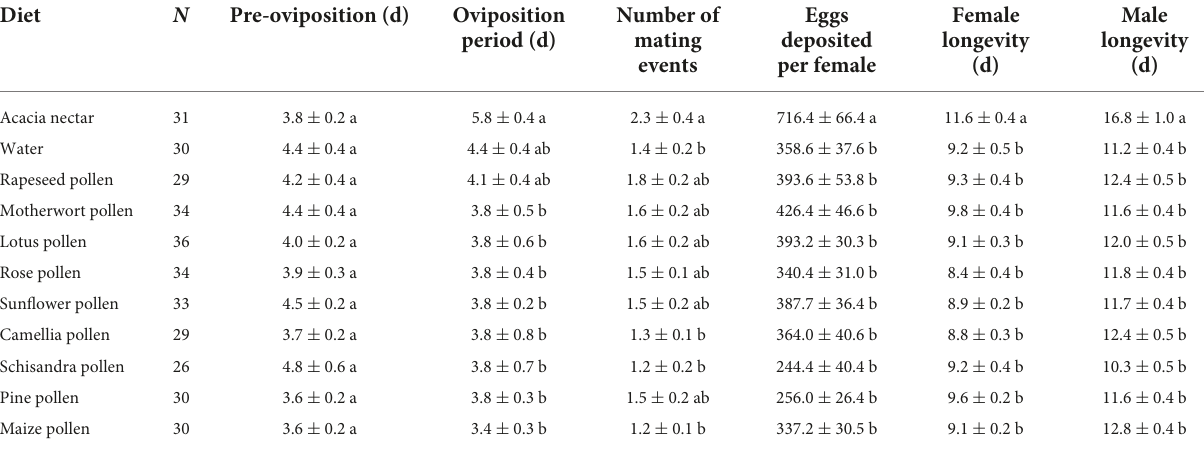
TABLE 5 Means ( ± SE) for longevity and fecundity variables for adults of Hadula trifolii on different